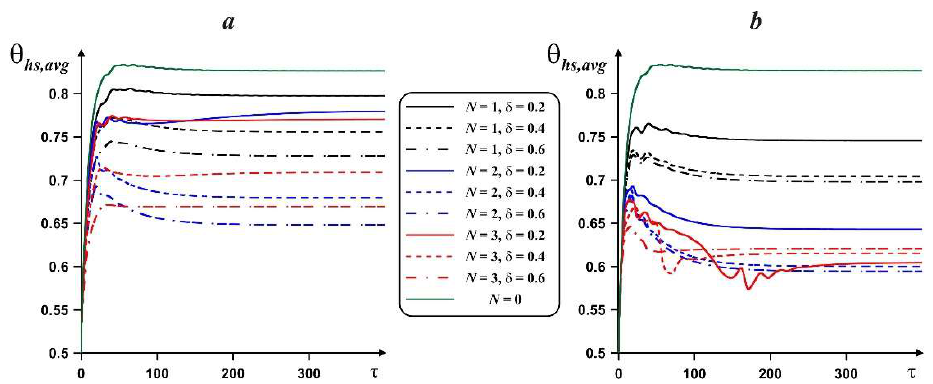
Figure 7. Dependences of average heater temperature on time, fins number and fins height at Ra = 10 5 : solid fins—( a ), porous fins at Da = 10 –5 , ε = 0.8—( b ).